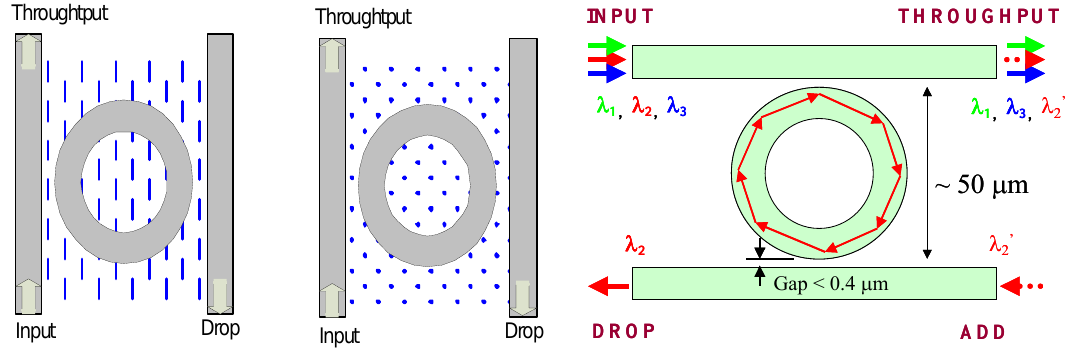
Figure 2. Electrically tunable microresonators using photoaligned LCs as the cladding layers, LC molecules switch between homogeneous (parallel) and homeotropic (perpendicular) orientation [22].